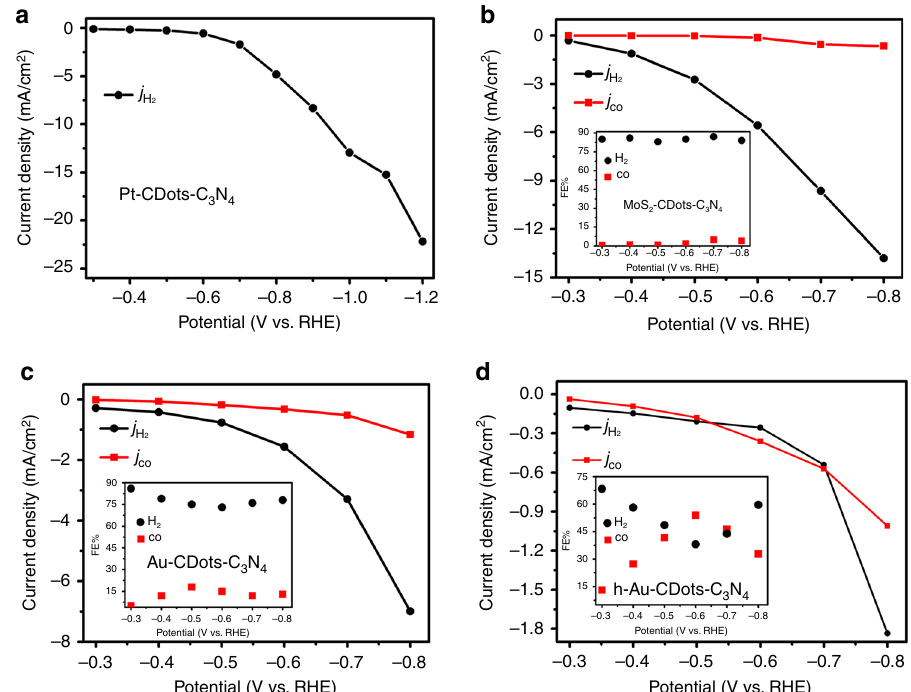
Fig. 5 Catalytic activity of composite catalysts with different HER catalysts. a Current density for HER ( j H2 , black trace) vs. the applied potential, catalyzed by Pt-CDots-C 3 N 4 in CO 2 -saturated 0.5 M KHCO 3 electrolyte. b Current density for HER ( j H2 , black trace) and current density for CO 2 reduction to CO, ( j co , red trace) and FEs of H 2 and CO (inset) vs. the applied potential, catalyzed by MoS 2 -CDots-C 3 N 4 in CO 2 -saturated 0.5 M KHCO 3 electrolyte. c Current density for HER ( j H2 , black trace) and current density for CO 2 reduction, ( j co , red trace) and FEs of H 2 and CO (inset) vs. the applied potential, catalyzed by Au-CDots-C 3 N 4 in CO 2 -saturated 0.5 M KHCO 3 electrolyte. d Current density for HER ( j H2 , black trace) and current density for CO 2 reduction, ( j co , red trace) and FEs of H 2 and CO (inset) vs. the applied potential, catalyzed by Au-CDots-C 3 N 4 in CO 2 -saturated 0.5 M KHCO 3 electrolyte. The amount of Au in d is half of that in c (marked as h-Au-CDots-C 3 N 4 ) leading to an increase of the CO/H 2 ratio in d with respect to that in KHCO 3 solution, pH = 7.2) and in an ionic liquid (without H + ). The current density – time curves of pure HER and syngas reactions at the potential of − 0.6 V (at − 0.6 V the syngas reaction produces ~90% CO) are shown in Fig. 4c. A stable current density (~ − 1.21 mA/cm 2 ) for syngas is observed at − 0.6 V while − 1.25 mA/cm 2 for HER is reached at the same potential. Then, ionic